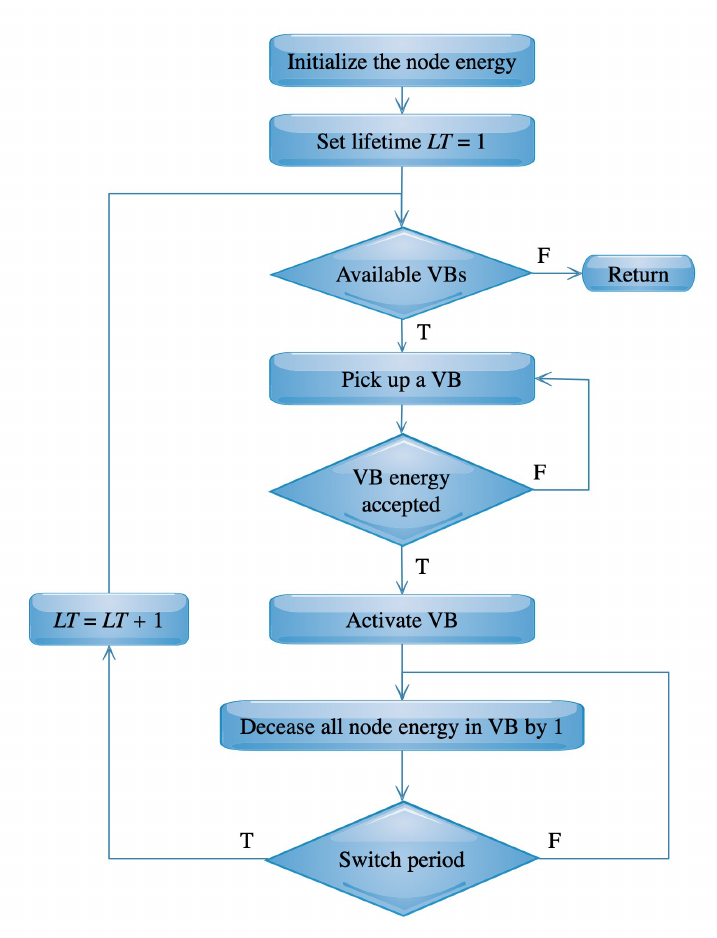
Figure 7. Step for computing the network lifetime LT in